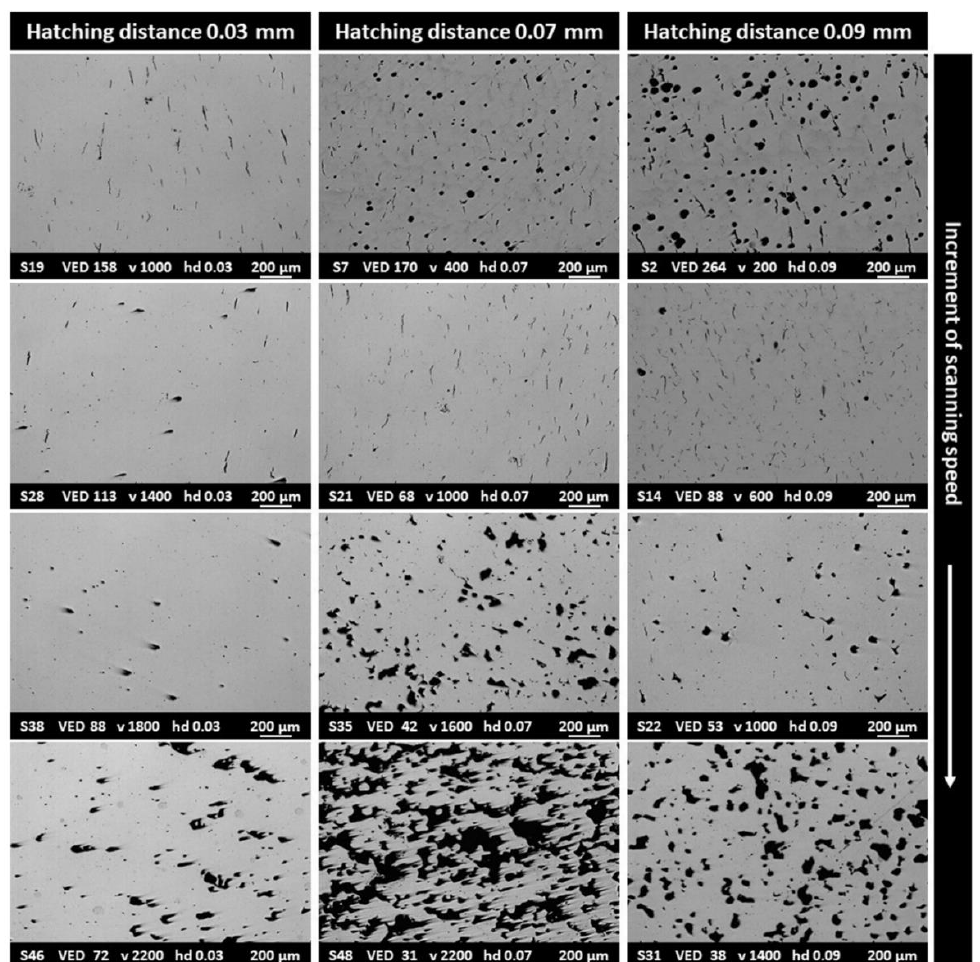
Figure 8. Representative LOM images of LPBFed IN939 fabricated using different process parameters. Note the laser power and layer thickness are constant at 95 W and 20 µm, respectively.